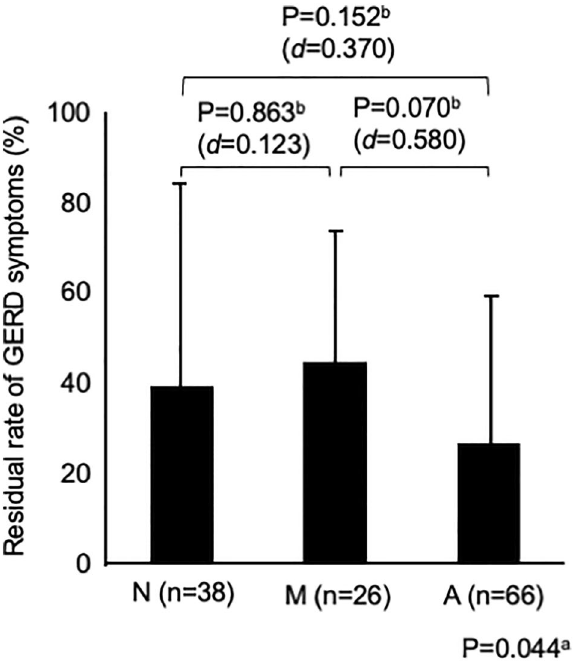
Figure 2. Comparison of symptom improvement among the three groups after 4 weeks of proton pump inhibitor administration: Residual rate of gastroesophageal reflux disease symptoms. NOTE: a = analysis of variance, b = Tukey’s honestly significant difference test, d = Cohen’s